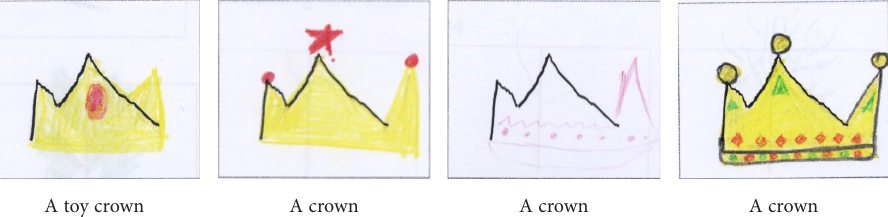
Figure 26. The creative task: interpretation of Fragment 4 – a crown (source: testingmom.com, 2020) The influence of physical environment on the process of interpretation can be identified by linking the fragment with animals by the participants (Tables 7, 8).